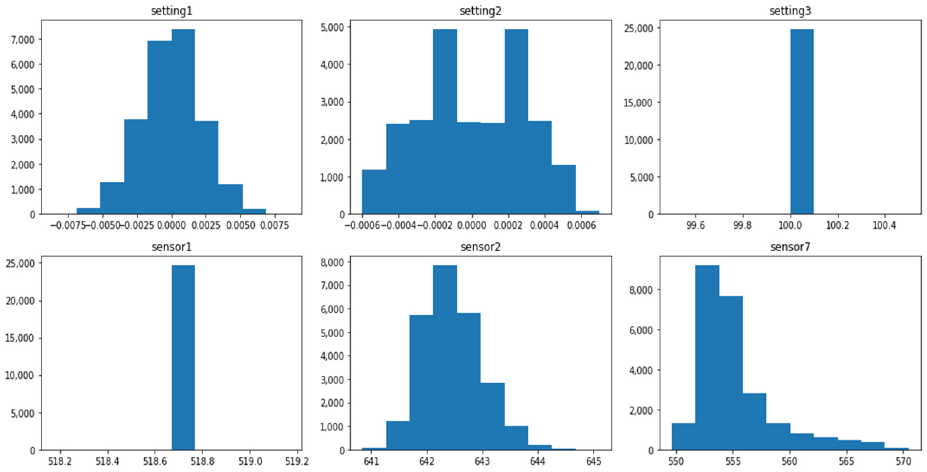
Figure 3. FD003_Train—distribution of selected variables.